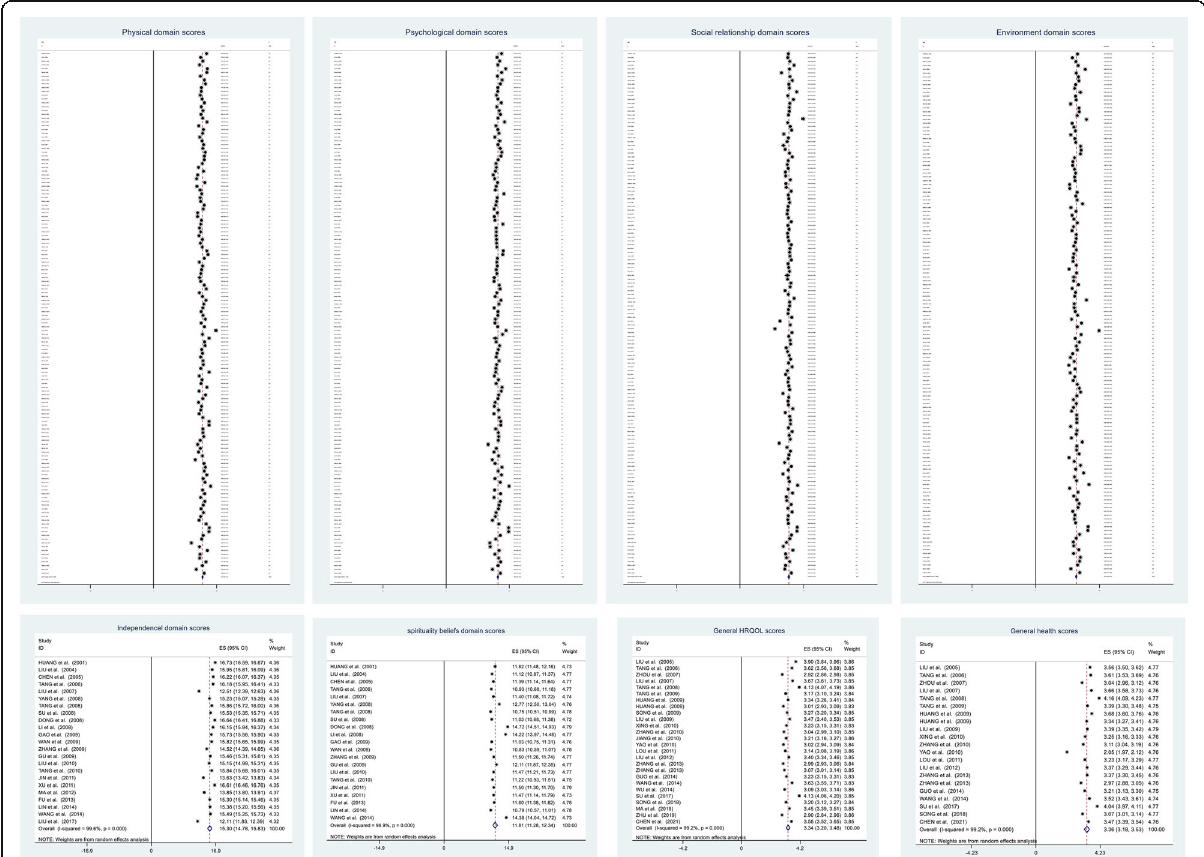
Fig. 2 Forest plot for scores in the physical, psychological, social relationship, environment, independence, and spirituality beliefs domains, general HRQOL and general health, China, inception-2021. Note: all analyses were based on a random-effects